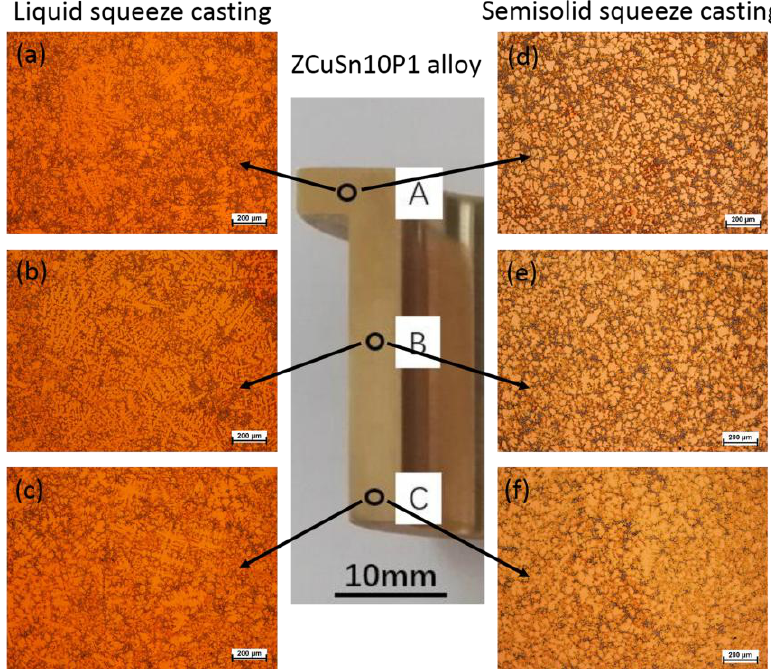
Figure 11. Comparison of microstructures of ZCuSn10P1 alloy parts obtained by liquid squeeze casting and semi-solid squeeze casting.